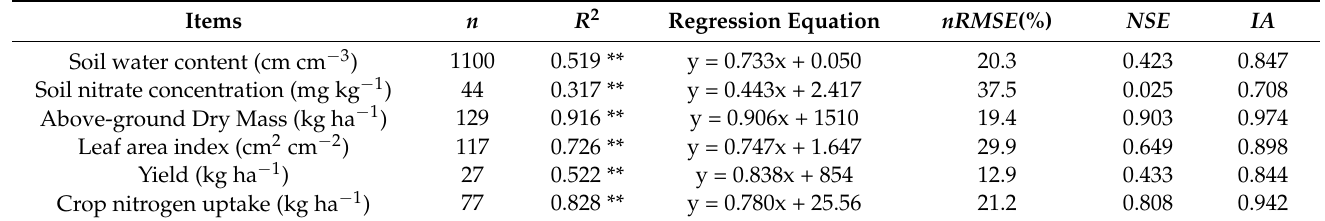
Table 4. Statistical indices for simulated soil water content, nitrate concentration, leaf area index, yield, and crop N uptake under different cropping